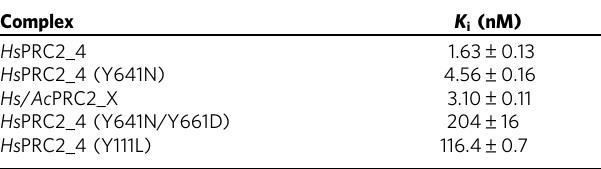
Table 1 | Biochemical analysis of inhibitor 1 potency ( n ¼ 2 for each K i ; the data are mean ± s.d.).